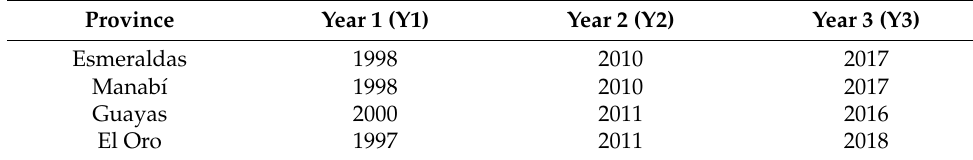
Table 3. Years analyzed by